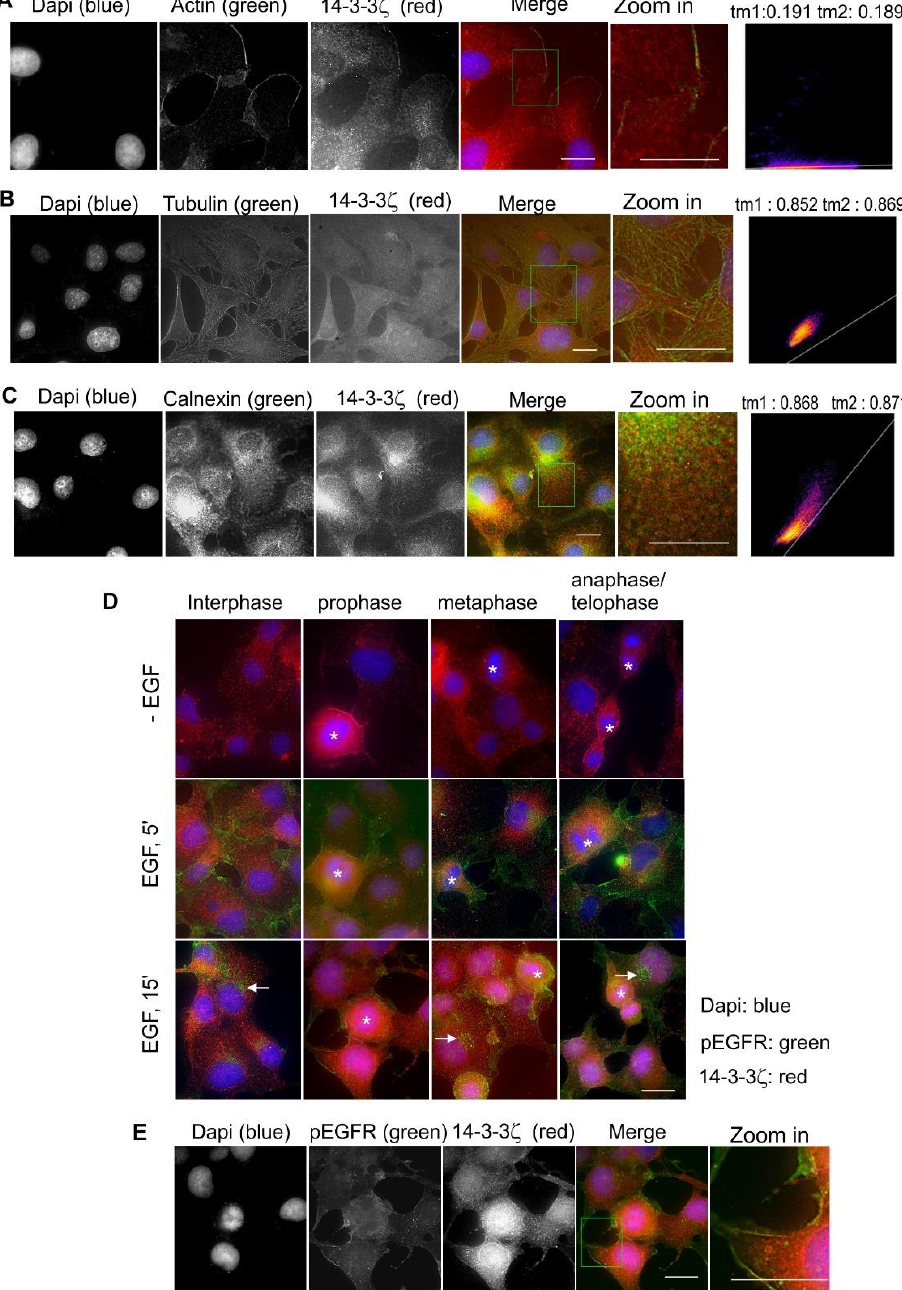
Figure 10. Subcellular localization of 14-3-3ζ in Cos-7 cells by double indirect immunofluorescence. ( A ) Co-localization of 14-3-3ζ (red) and actin (green); ( B ) co-localization of 14-3-3ζ (red) and tubulin (green); ( C ) co-localization of 14-3-3ζ (red) and calnexin (green). ( D ) Subcellular localization of 14-3-3ζ during the cell cycle and in response to EGF. With or without EGF stimulation, 14-3-3ζ (red) and pEGFR (green) were revealed by double indirect immunofluorescence. ( E ) Co-localization of 14-3-3ζ (red) and pEGFR (green) following EGF stimulation for 5 min. Mitotic cells are labeled by * and endosomes are marked by arrows. Scale bar = 10 μm.